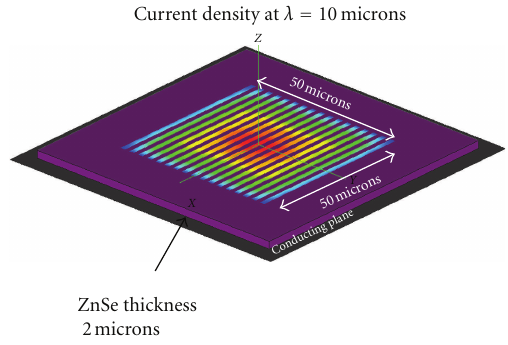
Figure 8: Current density distribution for a finite-sized resonant particle. Simulations were conducted using HFSS FEM solver.